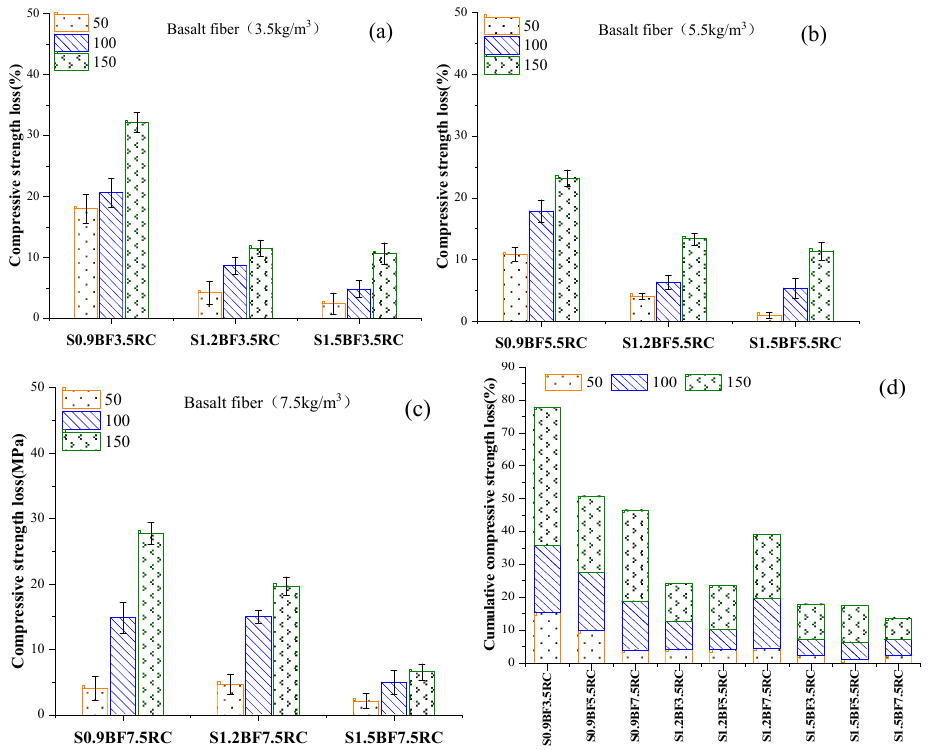
Figure 9. ( a – c ) Change in compressive strength rate during the freeze–thaw period. ( d ) Cumulative cubic compressive strength rate of the specimen.